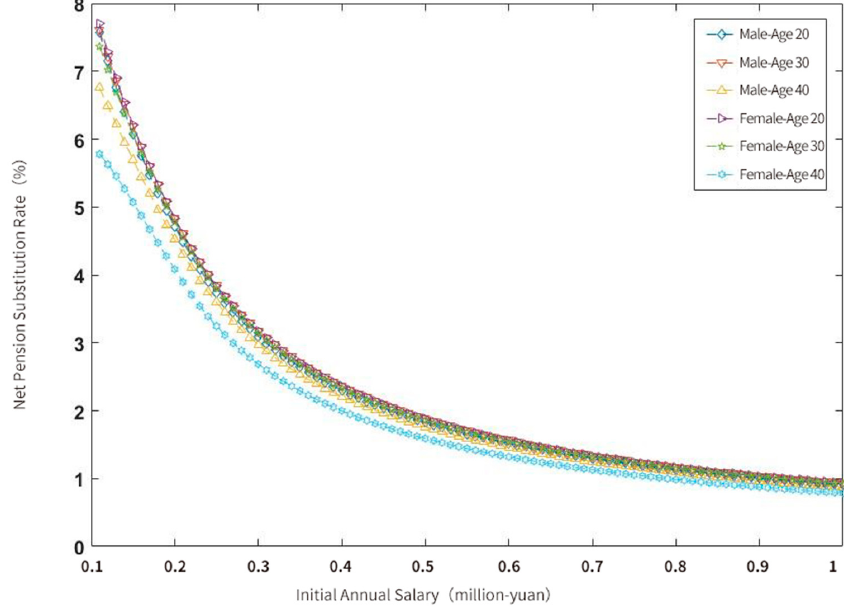
Figure 13. The impact of the initial insured annual salary on the net replacement rate.